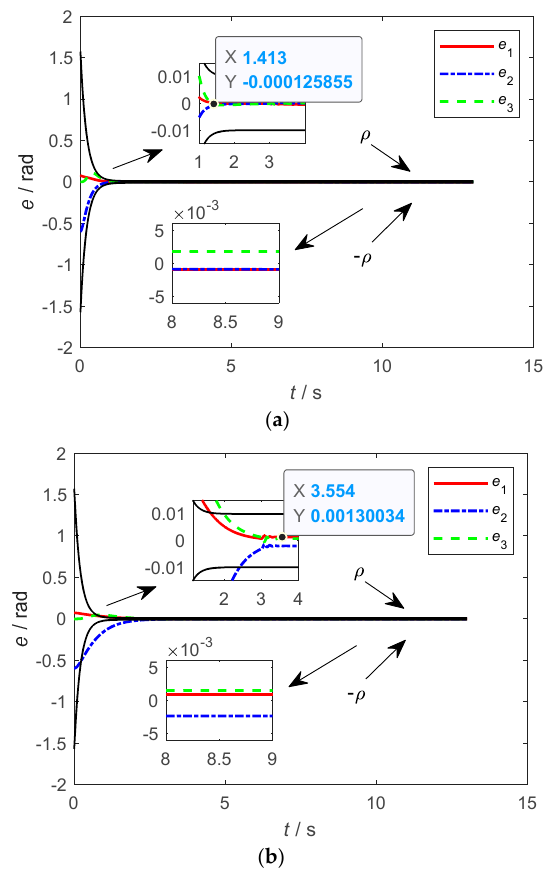
Figure 8. The joint tracking error curve of space robot end on-orbit insertion operation. ( a ) PPC. ( b ) SMC.